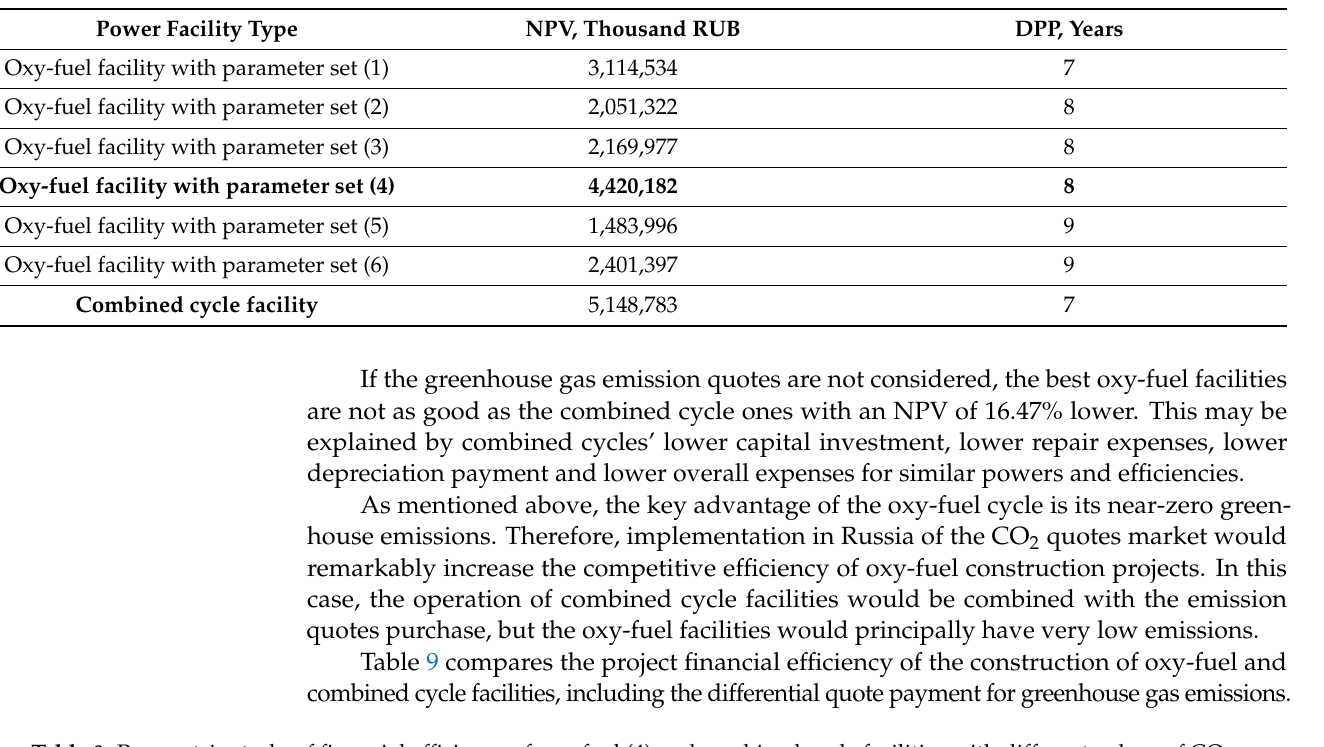
Table 9. Parametric study of financial efficiency of oxy-fuel (4) and combined cycle facilities with different values of CO 2 emission quote